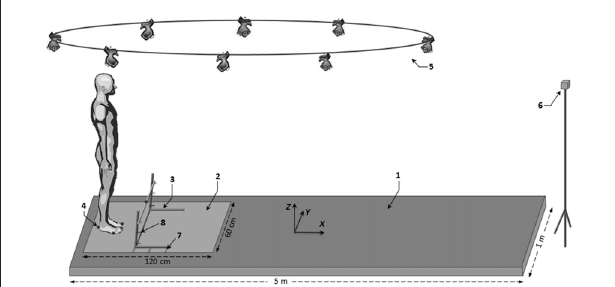
FIGURE 1 | Schematic illustration of the experimental set-up. Key: (1) walkway; (2) force-plate; (3) obstacle; (4) reflective marker; (5) Vicon camera; (6) visual target; (7) obstacle distance marker; and (8) obstacle height marker.